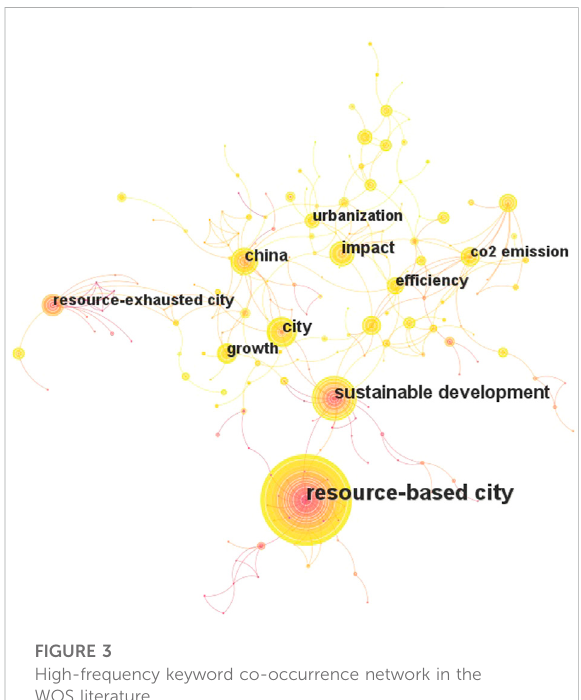
FIGURE 3 High-frequency keyword co-occurrence network in the WOS